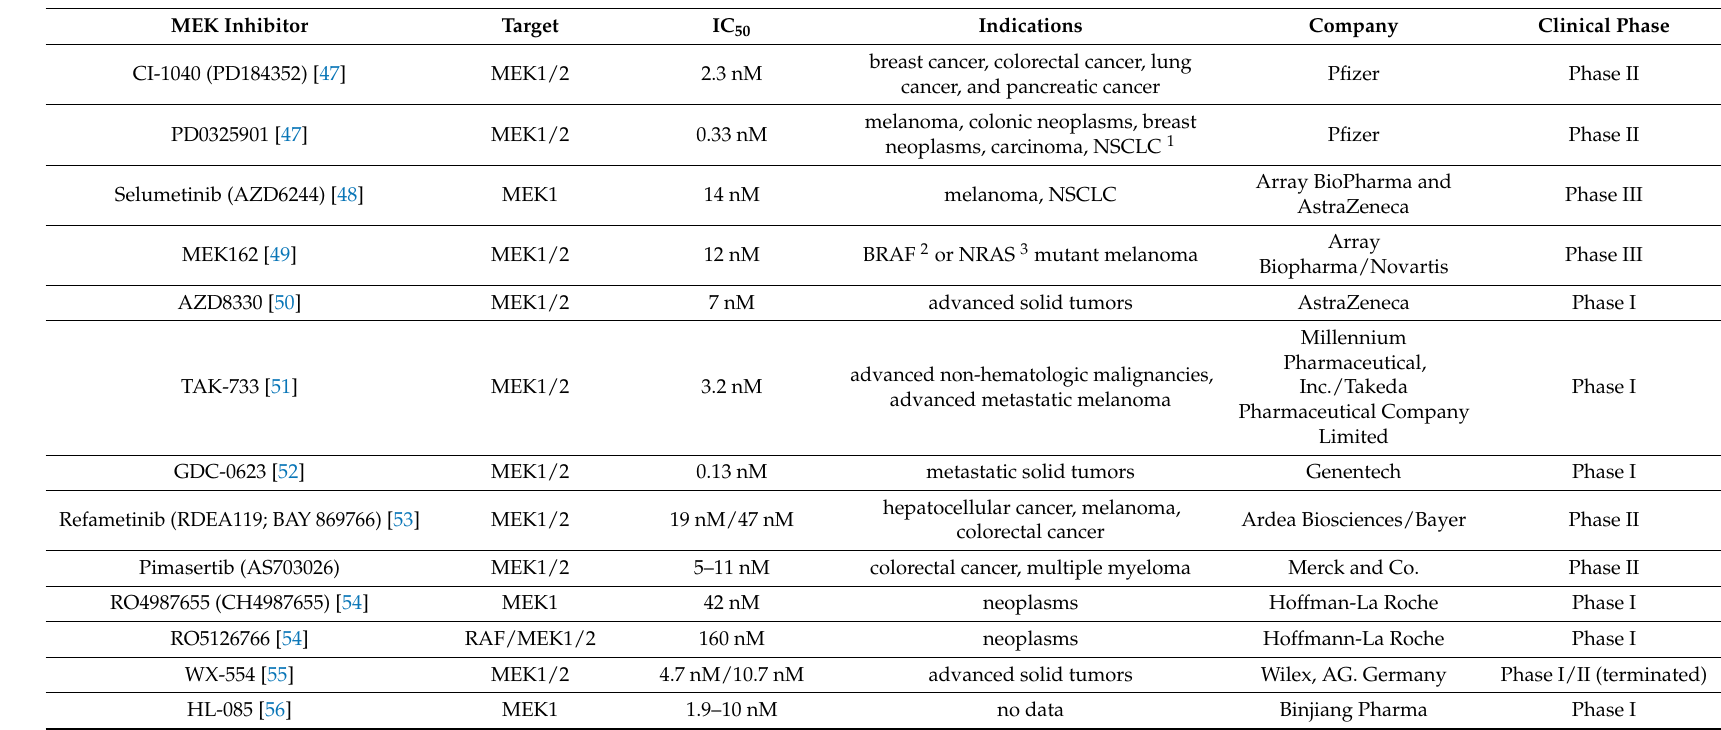
Table 2. MEK inhibitors in clinical